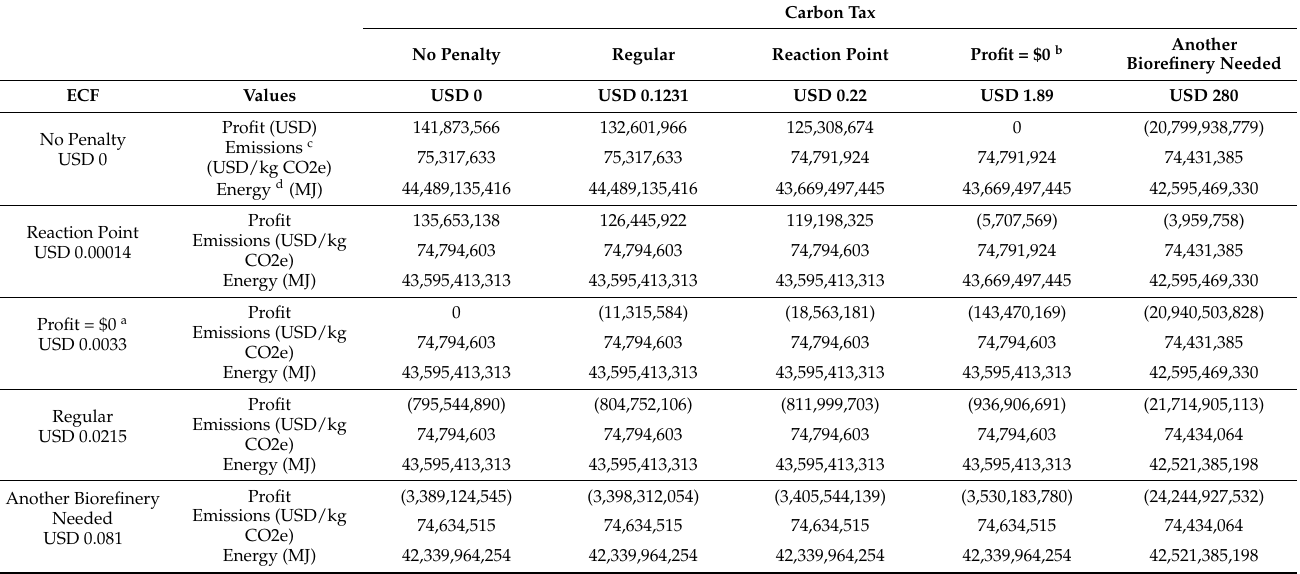
Table 11. Impact of different ECFs and carbon taxes on the total supply chain’s profit, energy, and emissions at the 300 MGPY demand